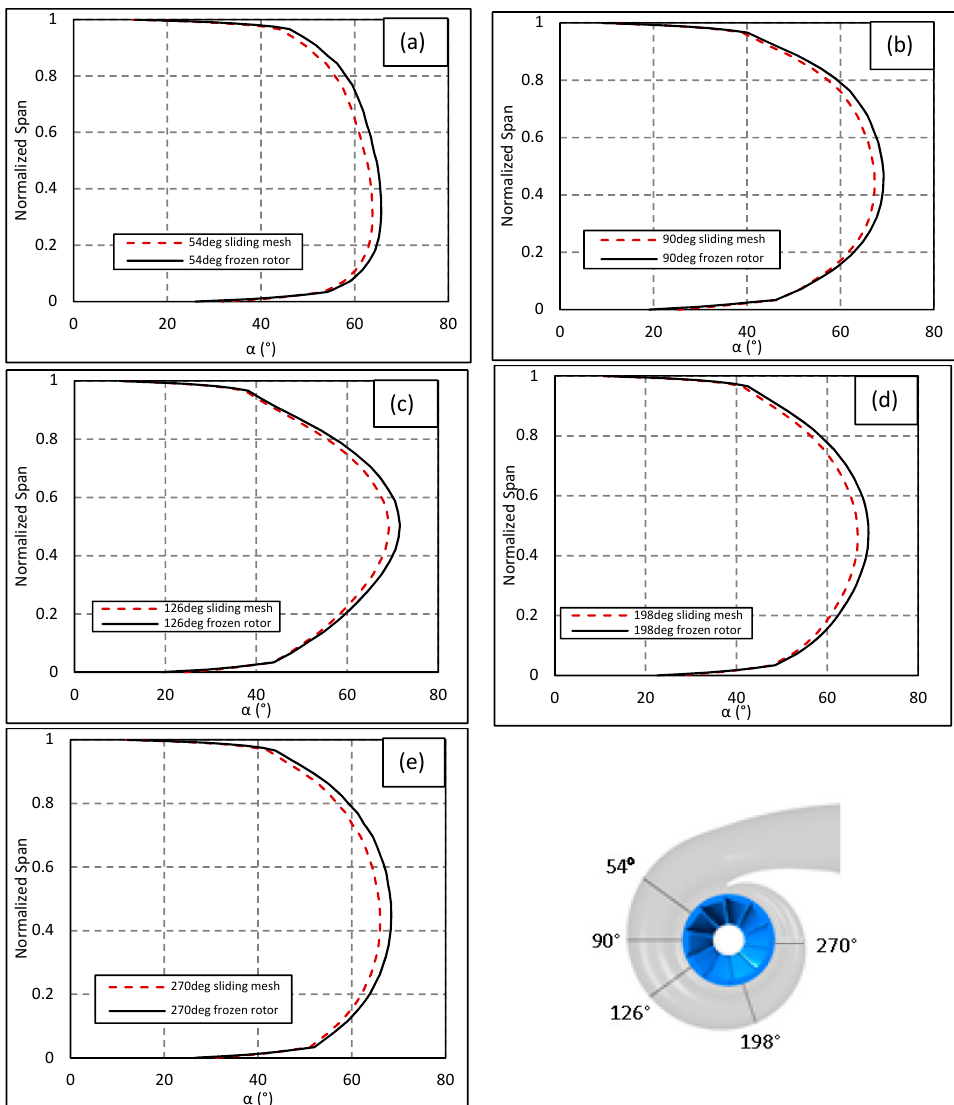
Figure 7. Comparison of absolute flow angle at volute exit using the frozen rotor and sliding mesh approaches. ( a ) 54°; ( b ) 90°; ( c ) 126°; ( d ) 198° and ( e ) 270°.